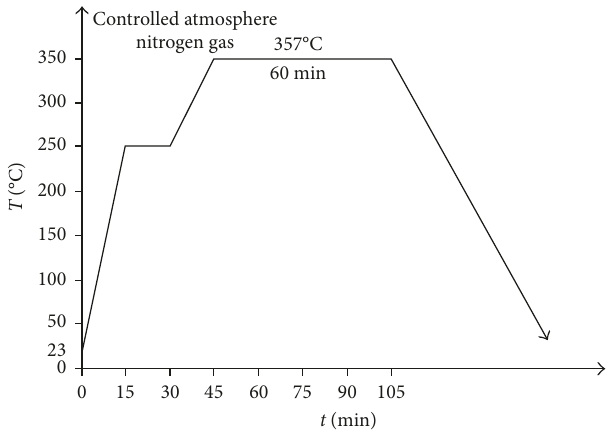
Figure 1: Sequence of the thermal treatment applied to the compacted Zn-Ni x powders for their densification in the solid